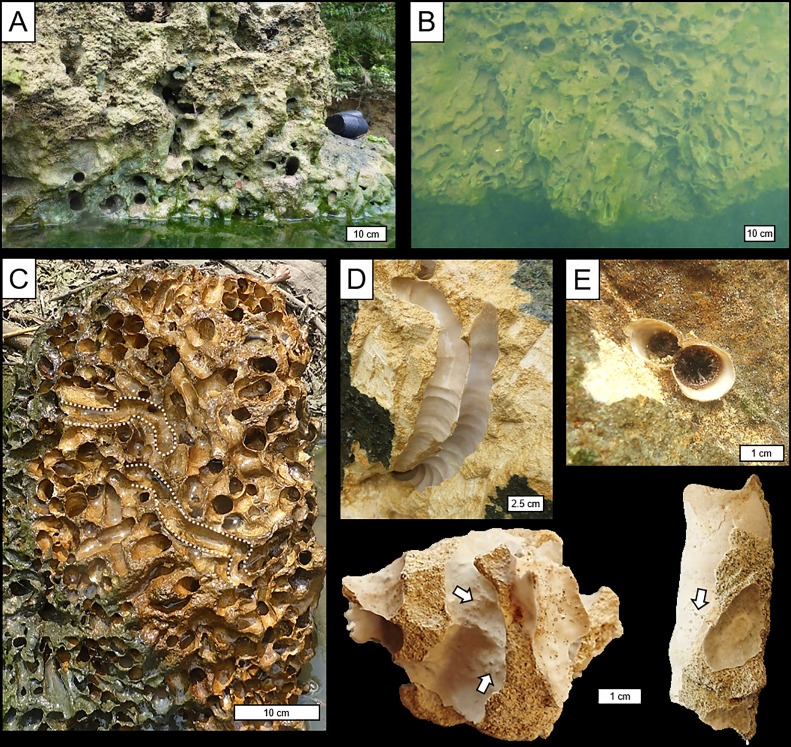
Borings of Lithoredo abatanica.(A, B) Borings exposed in river bank at low tide (A) and on submerged algae-coated limestone outcrop (B). (C) Densely emplaced borings (now vacated) in a limestone clast. Note tortuous paths of many borings (e.g., those partly outlined by white dashed lines). (D) Closely-spaced, calcite lined borings. Note axial distortion of the tunnel and transverse annulations in calcite lining. (E) Calcite-lined tunnel aperture showing figure-eight configuration, through which Lithoredo abatanica siphons protrude. (F, G) Close-up images of calcite tube interiors (F) and exterior (G) along with remnant limestone host rock (scale = 1 cm). Tiny xenoglyph bumps and pits, indicated by arrows in F and G respectively, reflect precipitation of the tube over larger sand-sized grains in the substrate.